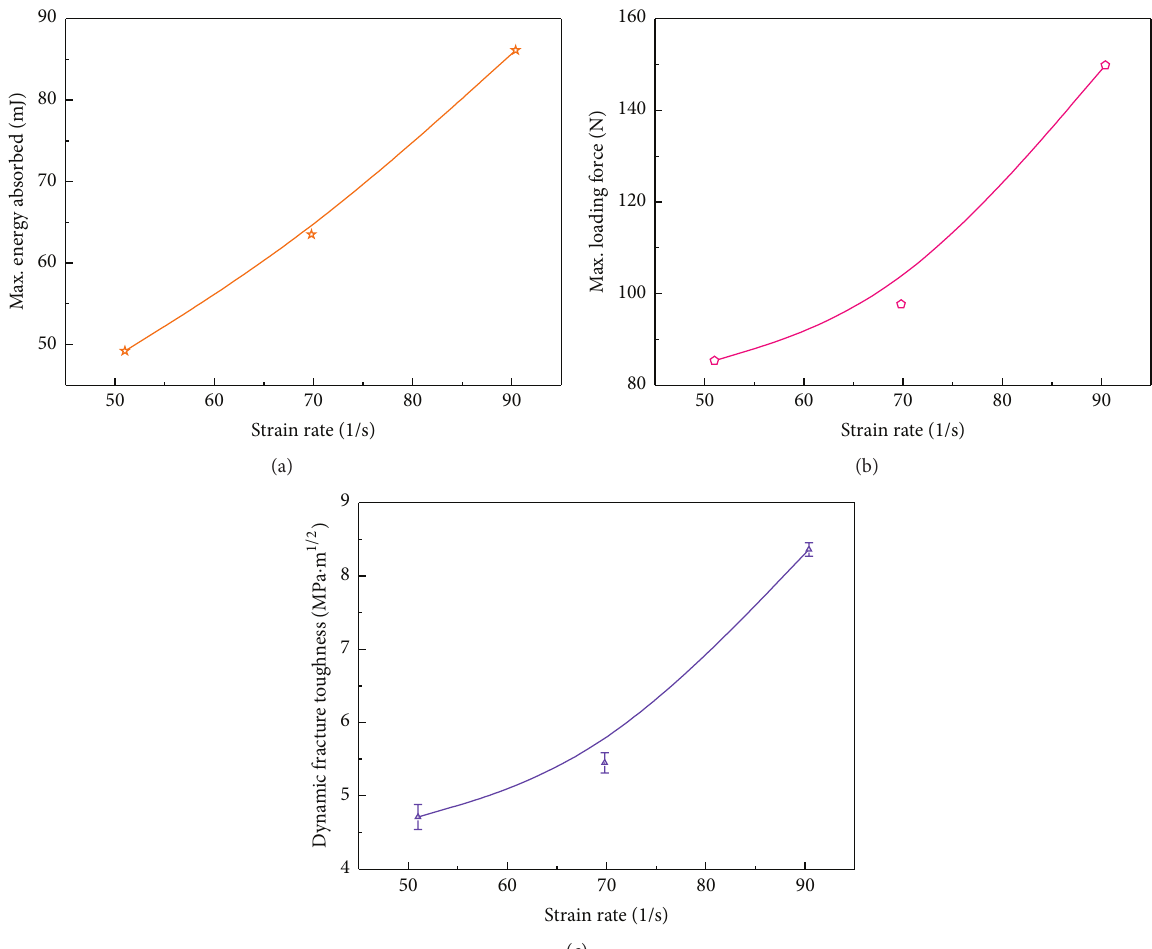
Figure 11: (a) Variation of maximum energy absorbed with strain rate, (b) variation of maximum loading force with strain rate, and (c) variation of fracture toughness with strain rate.